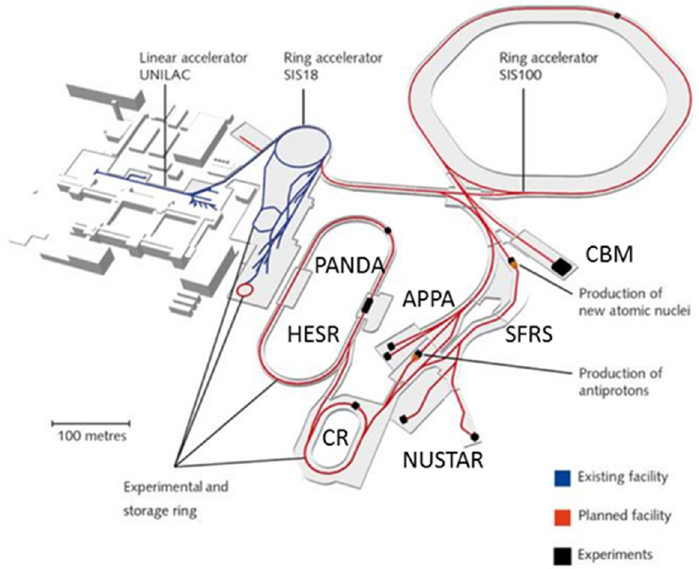
Figure 9. Layout of GSI and FAIR (see text) [45,46].